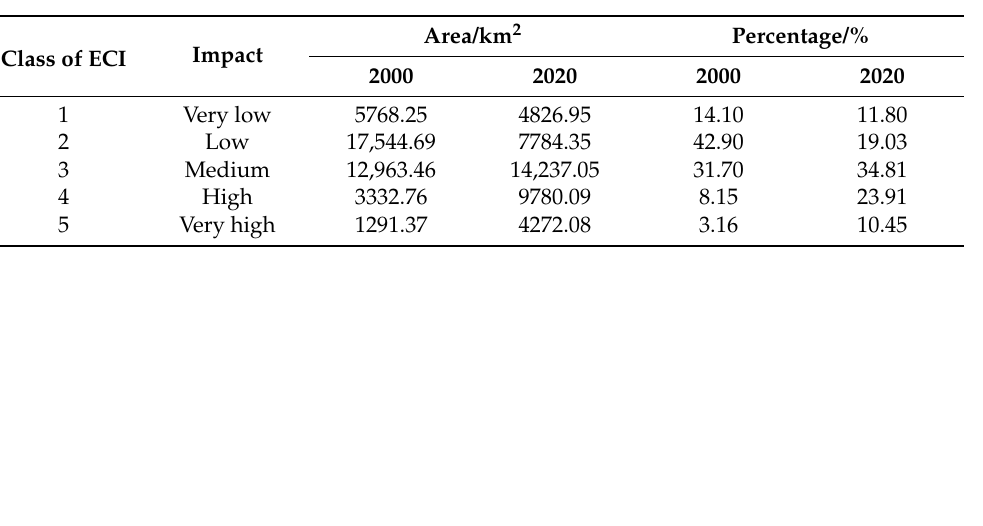
Table 7. Results of ECI classification for the Three Parallel Rivers Natural World Heritage